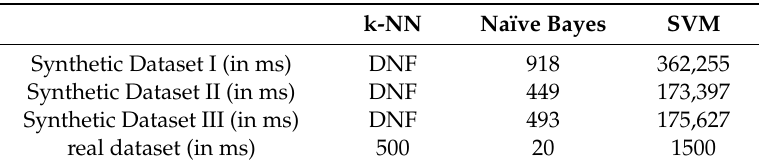
Table 2. Time needed to compute decision boundaries.